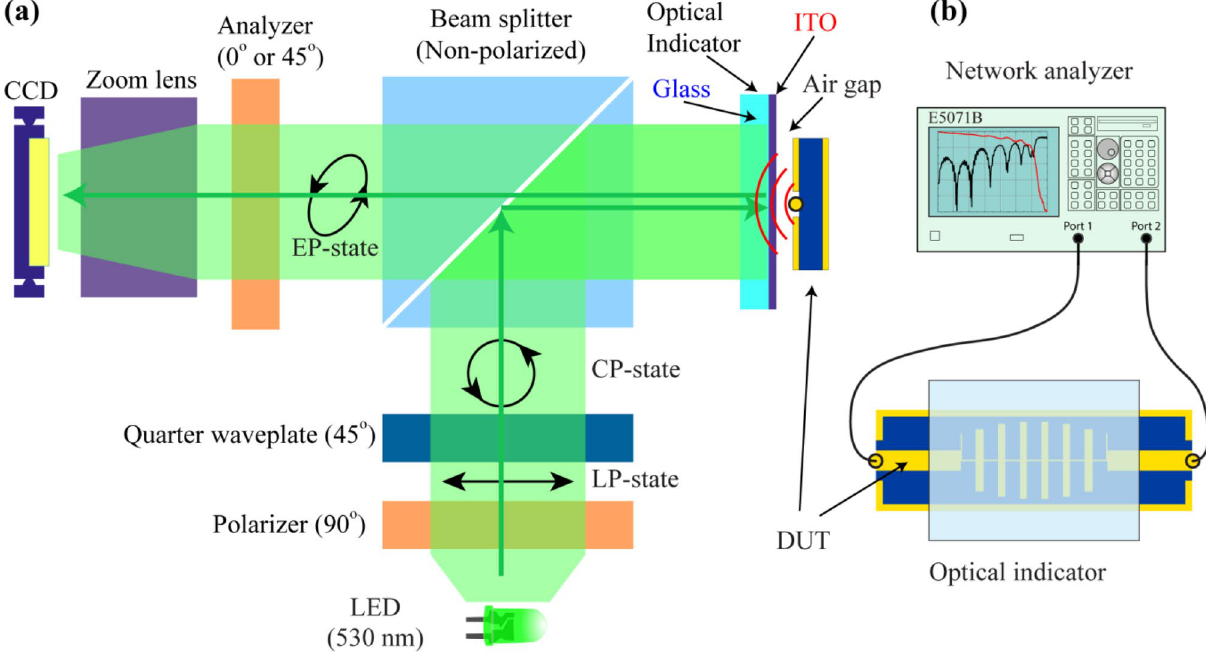
Figure 1. ( a ) Illustration of the visualization system. Successively, light passes through a linear polarizer and a quarter waveplate, consequently becoming circularly polarized. Probing light is directed to an OI fixed on a DUT. The light reflected from the OI passes through the analyzer (linear polarizer sheet), and the CCD camera registers the intensity of the light. ( b ) The configuration of the DUT connected with a network analyzer. The ITO was placed on the structure of the device with a small air